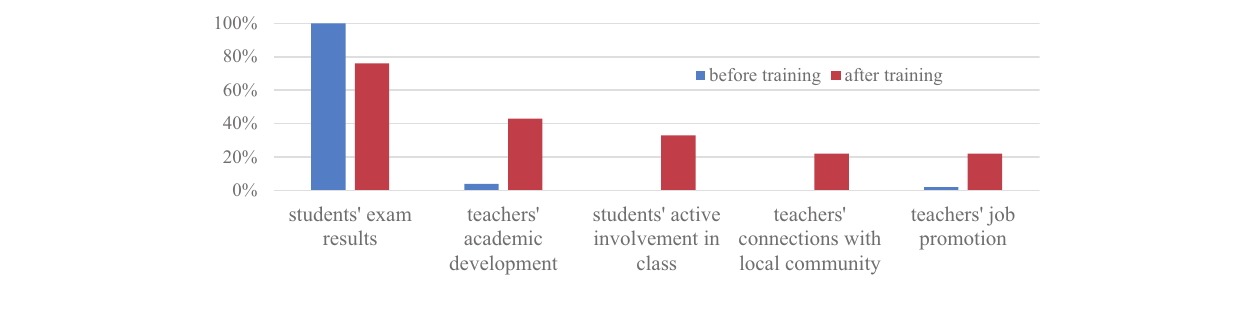
FIGURE 4 | Rural teachers’ achievement at work before and after taking the